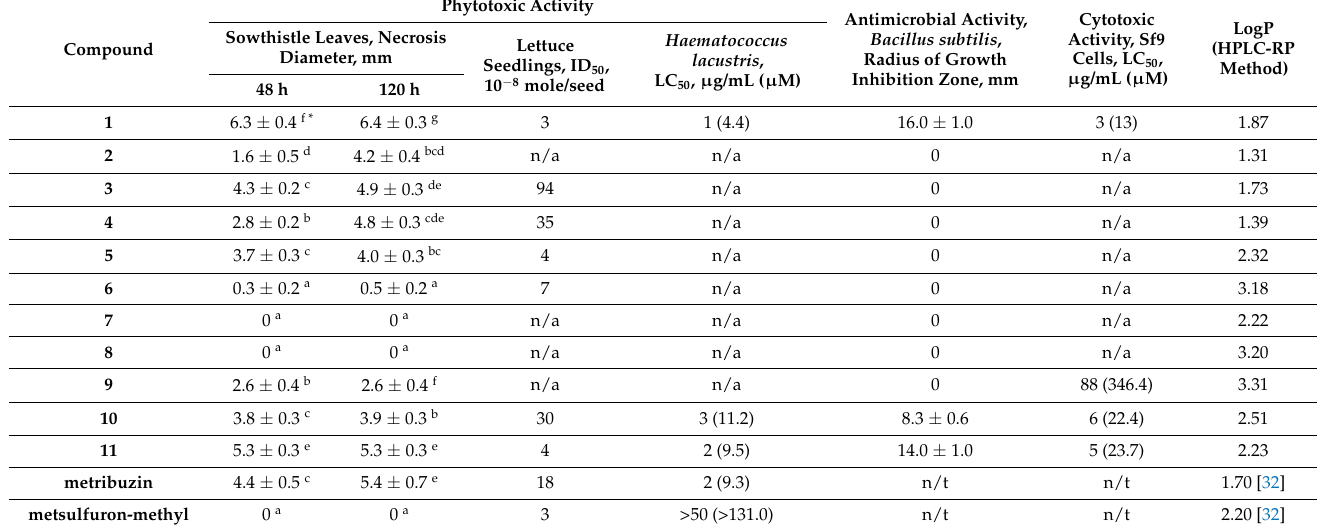
* Letters indicate statistically significant differences ( p =0.05), n/a—not active, n/t—not